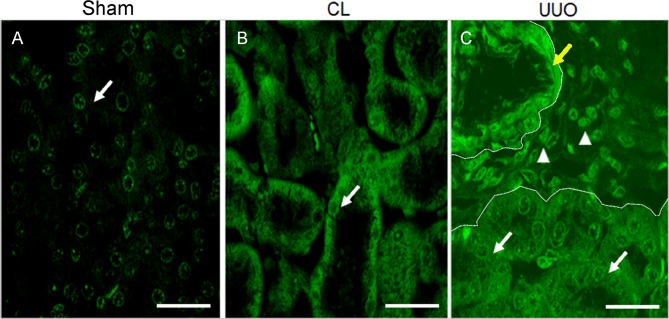
Representative micrographs of the 4 hydroxynonenal (4-HNE) immunofluorescence.(A) Sham histological kidney section; arrow points to the faint immunofluorescence staining of a tubular cell; bar: 28 μm. (B) CL kidney section; arrow points to the diffuse fluorescence in cortical tubule cells; bar: 28 μm. (C) UUO: moderate, diffuse immunofluorescence in all tubules (arrows), inflammatory cells (arrow heads), and intense staining in arterial muscle layer cells (yellow arrow); bar: 28 μm. Dotted lines delimitate an interstitial area.